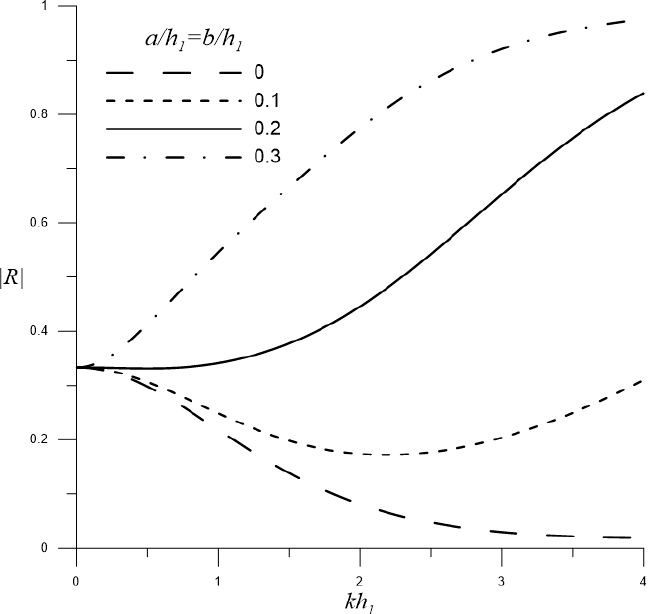
Figure 12. Reflection coefficient | R | varying against kh 1 for the case of two barriers with different barrier lengths.